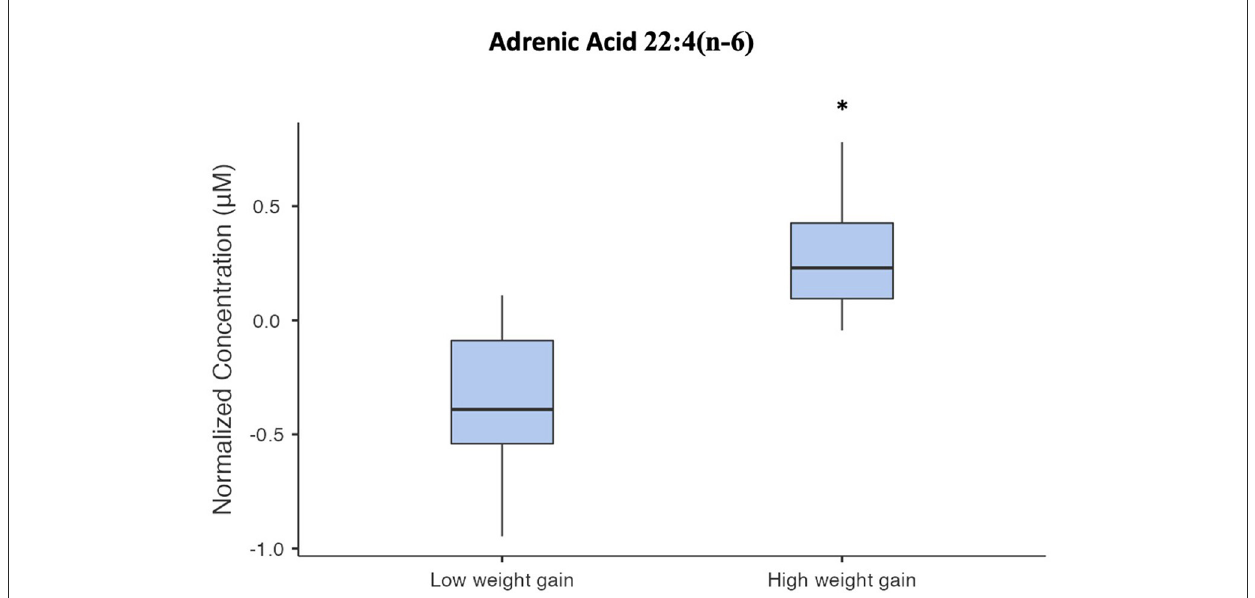
FIGURE1 Box and whisker plot of normalized serum adrenic acid concentrations. The asterisk indicates that adrenic acid concentrations in the high-weight gain group were significantly different from the low-weight gain group (FDR =